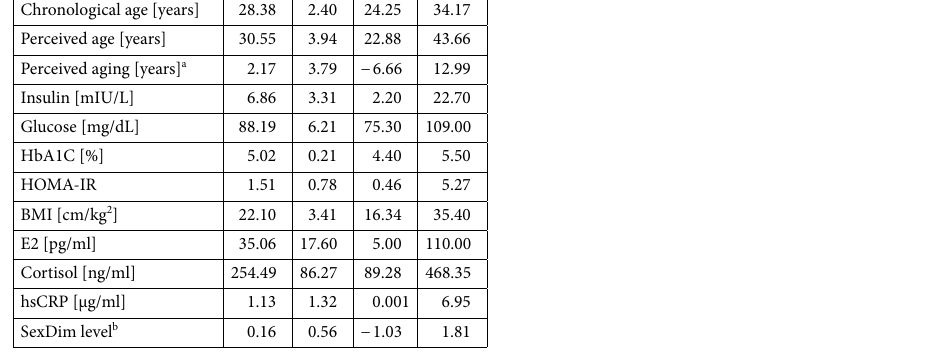
Table 2. Descriptive statistics of the studied variables in women (N = 163). a Difference between perceived and chronological age. b The level of sexual dimorphism.